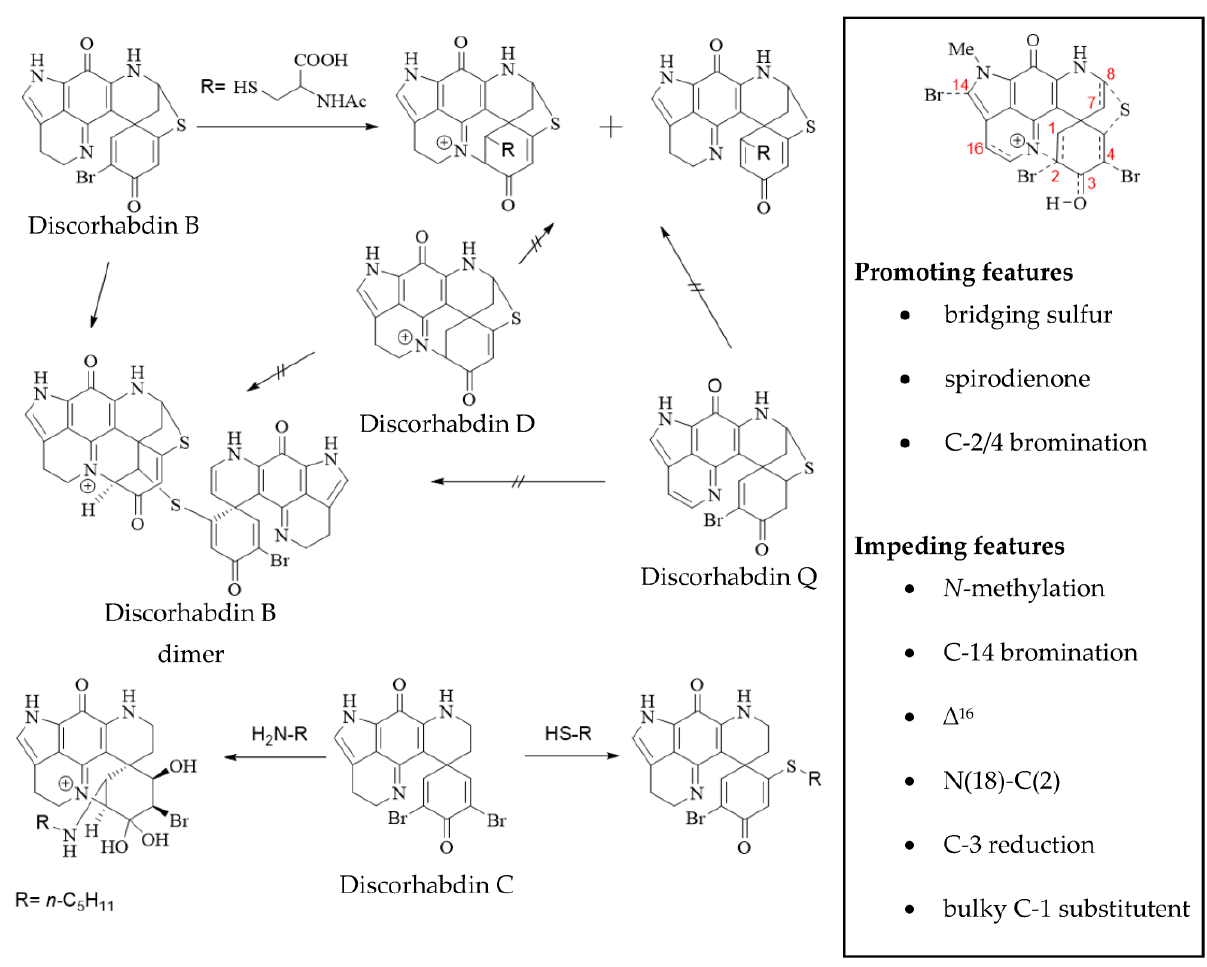
Figure 7. Electrophilic reactivity of discorhabdin B and discorhabdin C (adapted from references [70,71,73]) and structure-activity relationship of discorhabdin cytotoxicity (adapted from references [3,22,71,72]). Table 1. Anti-tumor activity of natural pyrroloiminoquinones against tumor xenografts in mouse